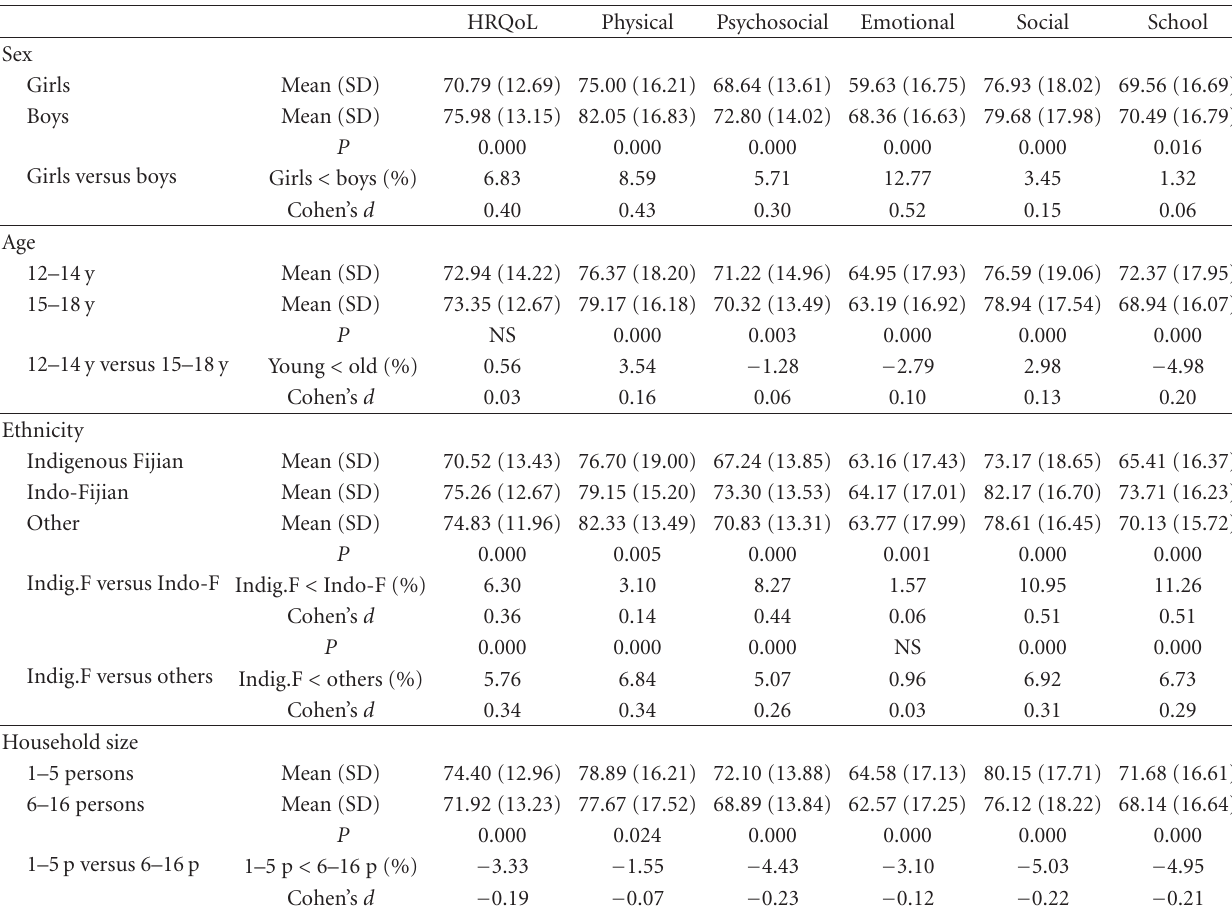
Table 3: Self-rated health-related quality of life (HRQoL) by sociodemography in 12–18-year-old school children in Fiji. HRQoL Physical Psychosocial Emotional Social School